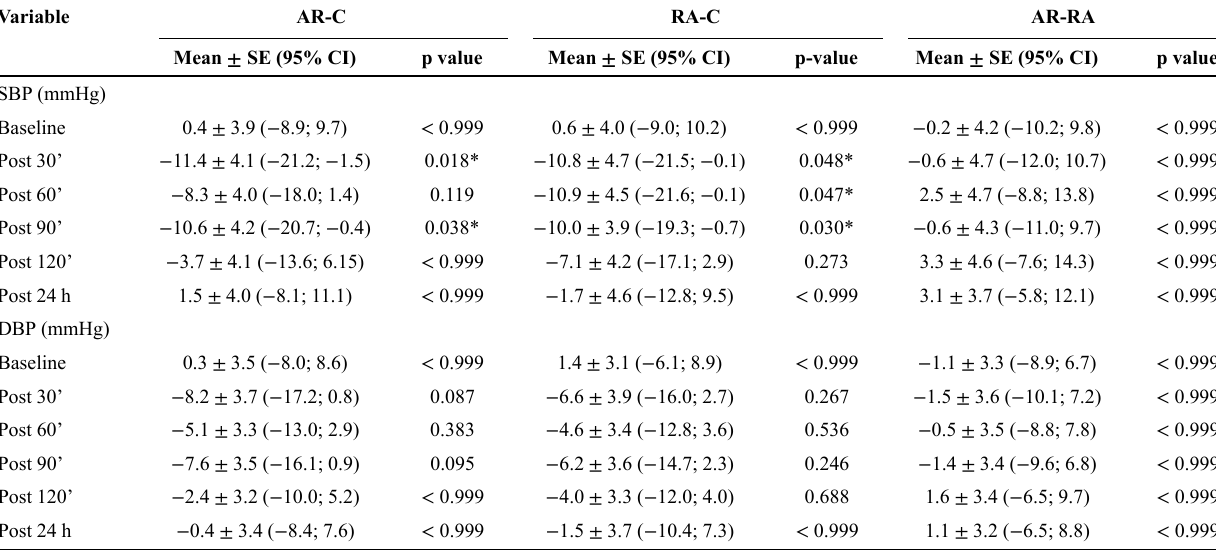
Table 2 - Differences in SBP and DBP between exercise sessions in relation to the control session (AR-C and RA-C) and between exercise sessions (AR- RA). Variable